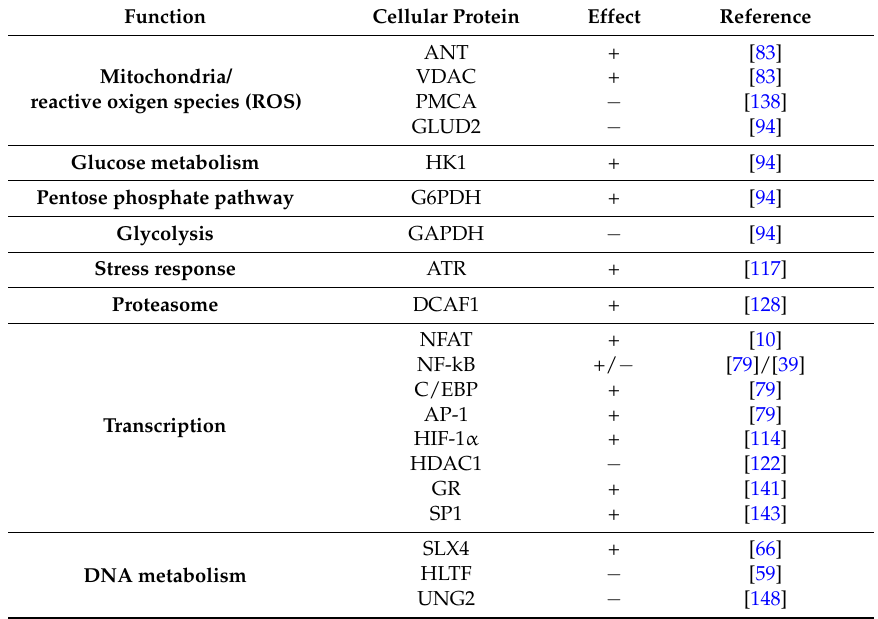
Table 1. Cellular proteins modulated by Vpr protein. (+): activation/increase; ( − ): inhibition/decrease. Function Cellular